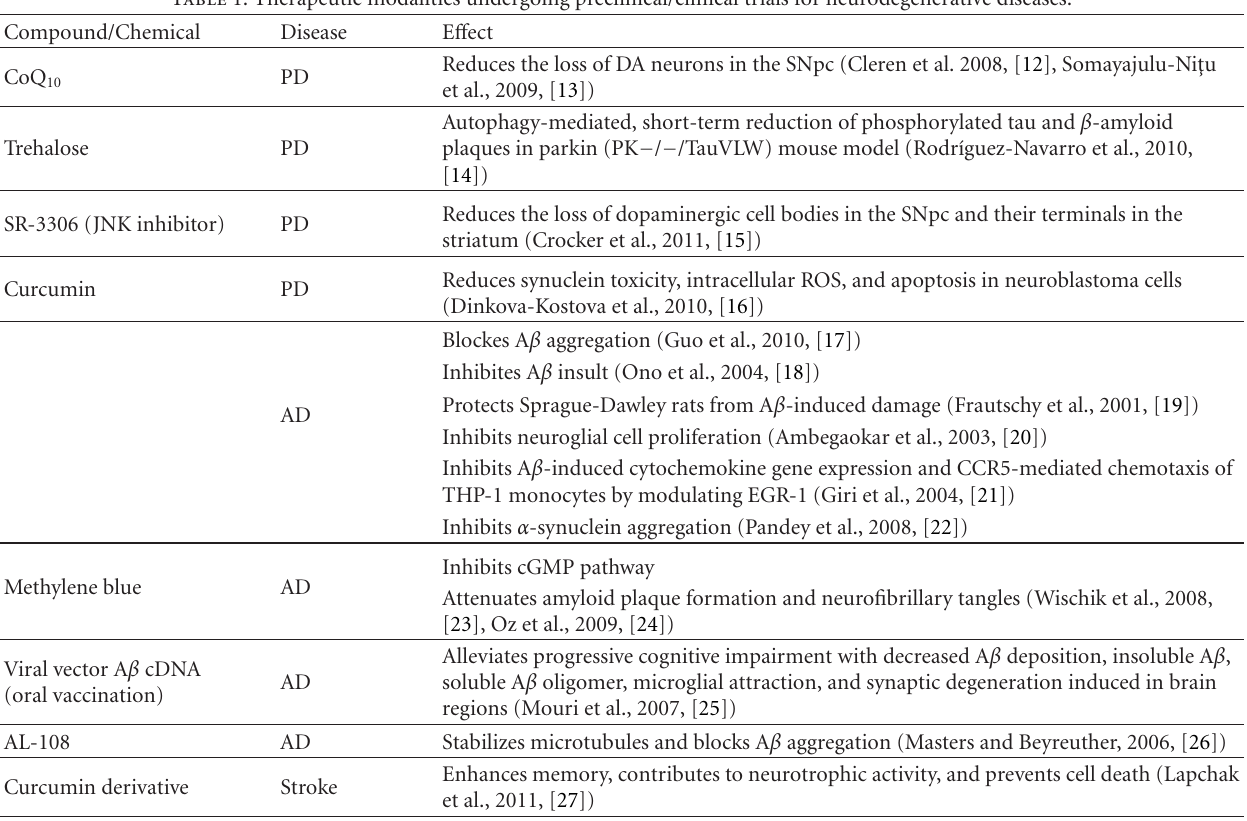
Table 1: Therapeutic modalities undergoing preclinical/clinical trials for neurodegenerative